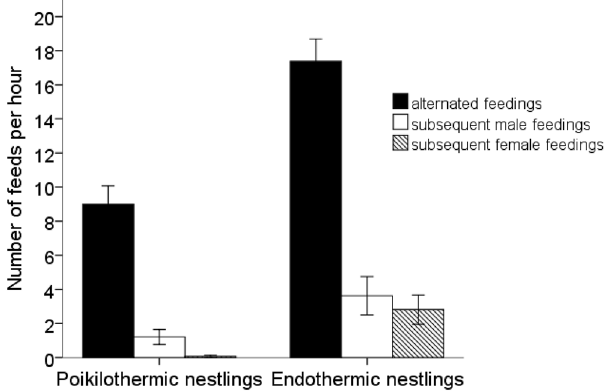
Figure 5. The ratio of alternated parental feeding trips and feeding trips performed subsequently by males and females in nests containing poikilothermic nestlings (n = 14) and endothermic nestlings (n = 16), whiskers represent 1